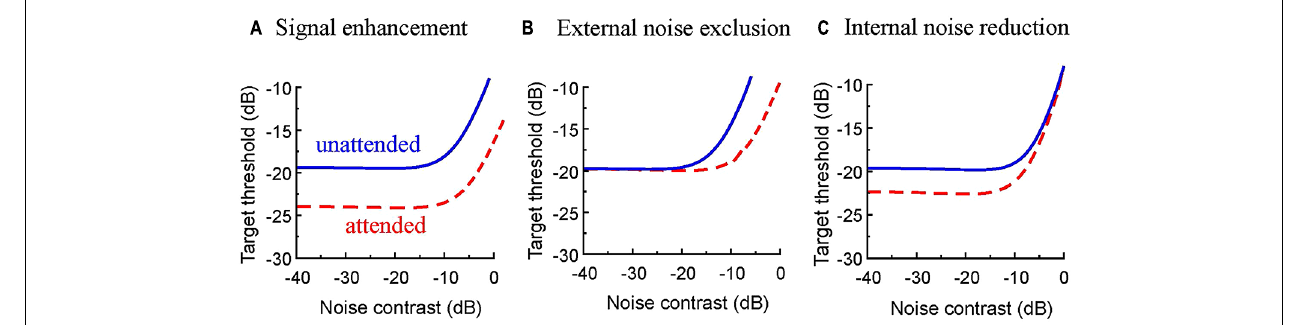
that the same external noise level can have different effects on target detection in the attended and unattended conditions.This suggests that attention allows the participants to exclude noise in the stimuli more easily. This corresponds to a reduction of the contribution from the external noise [ w m in Eq. (5)] in our model. (C) If theTvC functions showed a vertical shift at low noise contrast, but merged at high contrasts, the effect of attention is to reduce the internal noise.This corresponds to a reduction of the internal noise parameter [ σ 2 a in Eq. (6)] in our